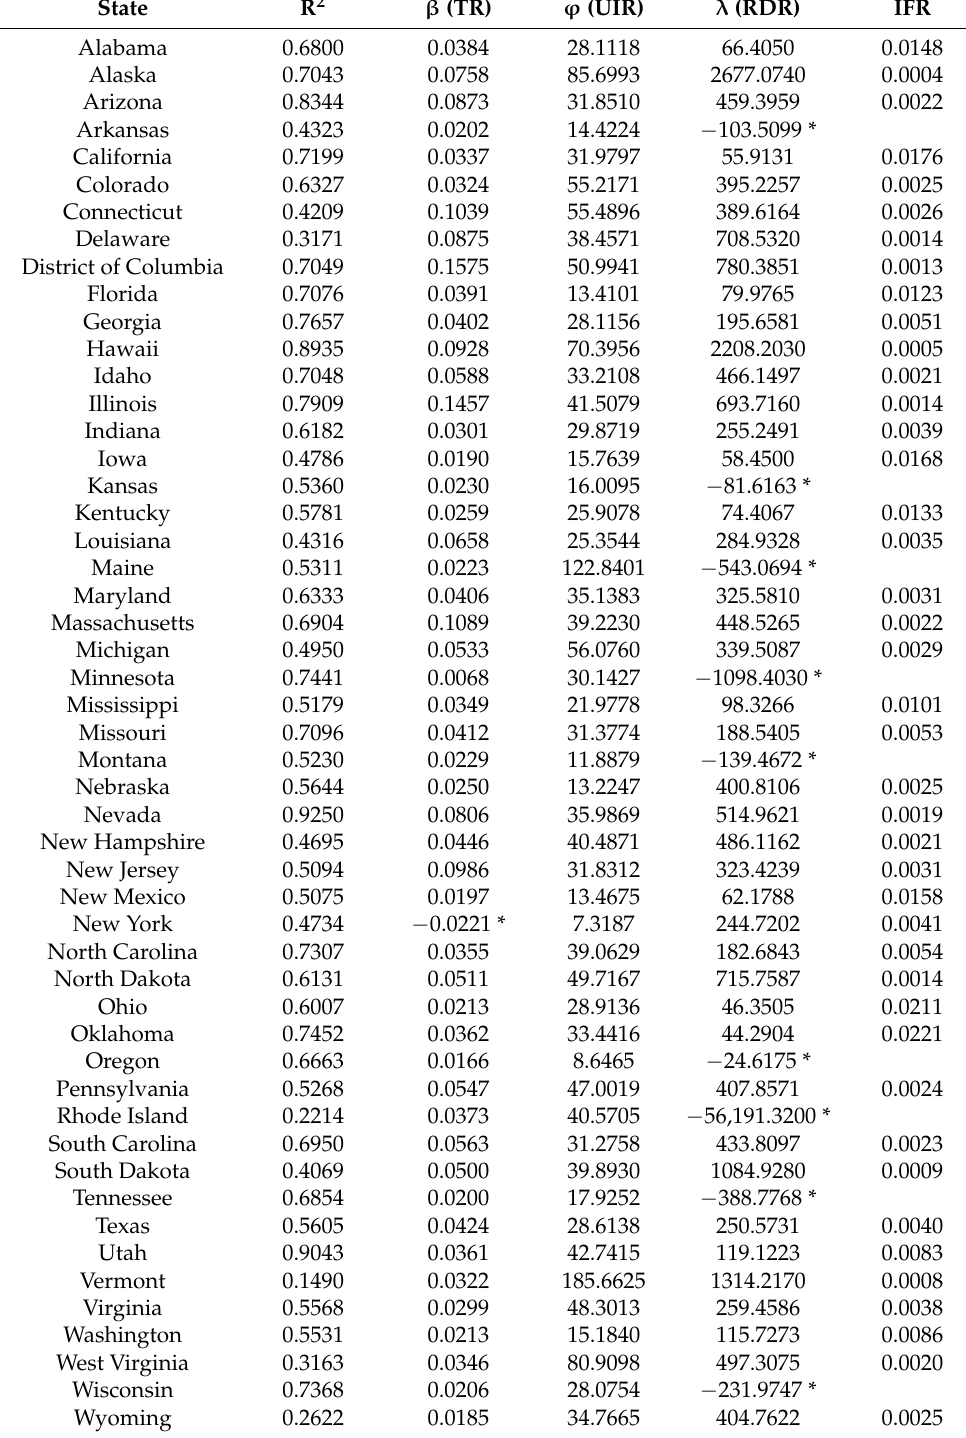
Table A1. Parameters Estimated by Equation (7) on State